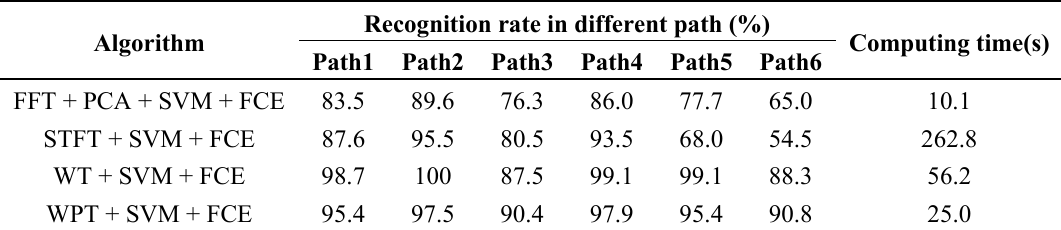
Table 3. Comparison of Recognition Results Based On Different Fusion